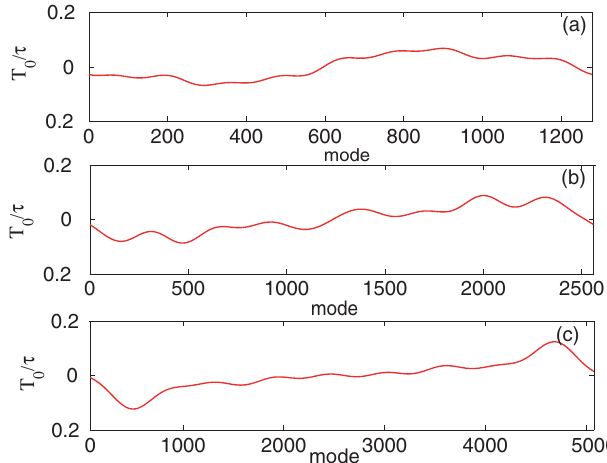
FIG. 7. (Color) Growth rate of vertical coupled-bunch instability estimated by the wake field in Fig. 5. A positive rate indicates instability. Plots (a), (b), and (c) depict mode spectra for 2, 4, and 8 ns spacing. Primary electrons are produced at a photon- illuminated position, 30% of them are produced uniformly on the chamber surface, and secondary electrons are produced with (cid:1) 1 : 0 the rate, (cid:3) 2max